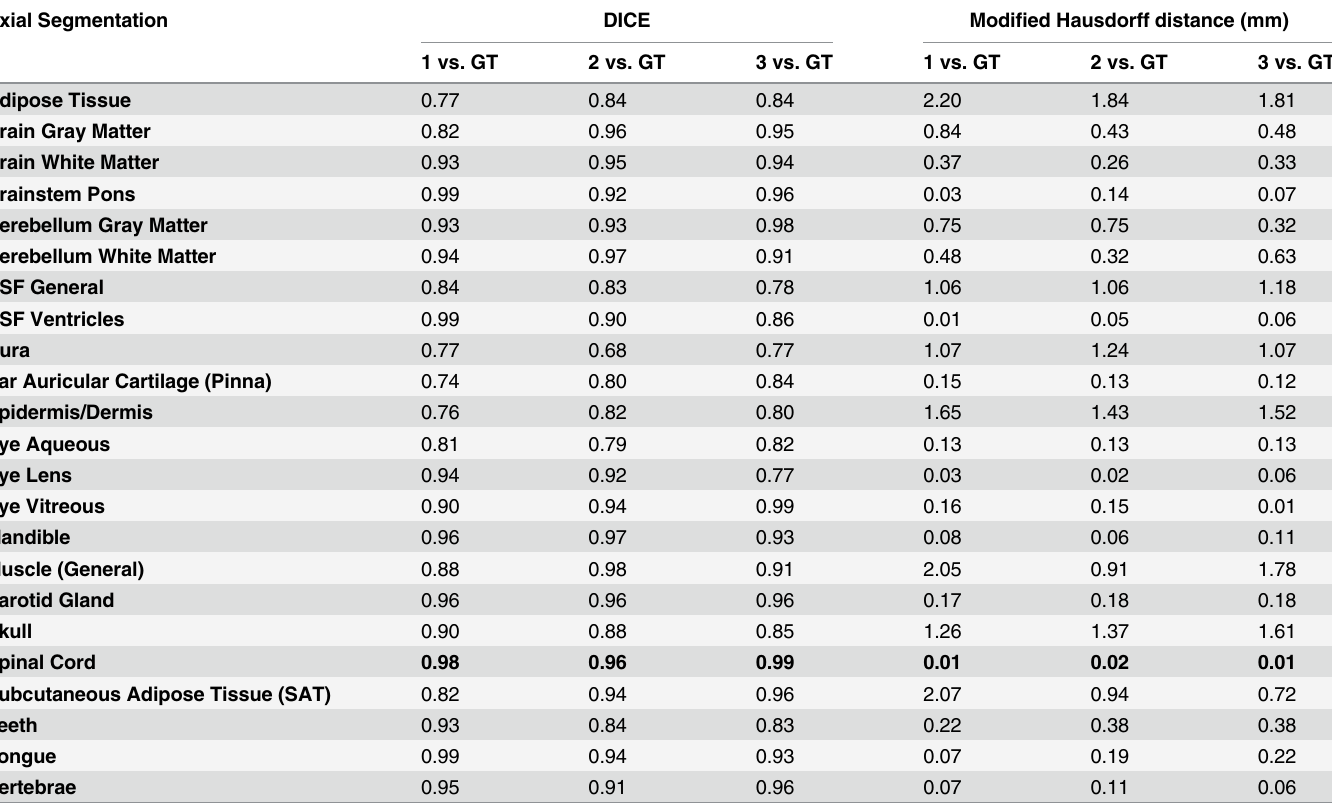
Table 3. Inter-operator variability across structures assessed on the axial